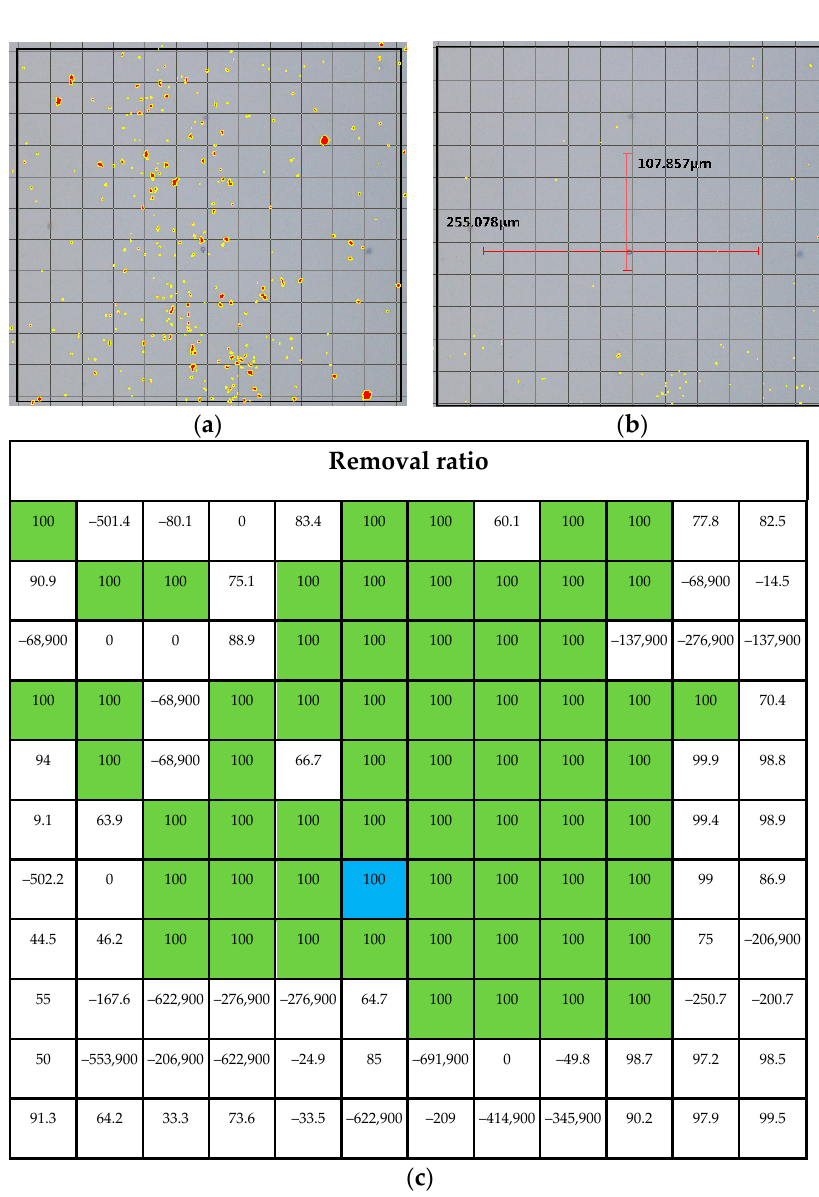
40 Figure 14. Particle distribution analysis of Figure 13. ~1 1~2 2~3 3~4 4~5 5~6 6~7 7~8 8~9 9~100 20